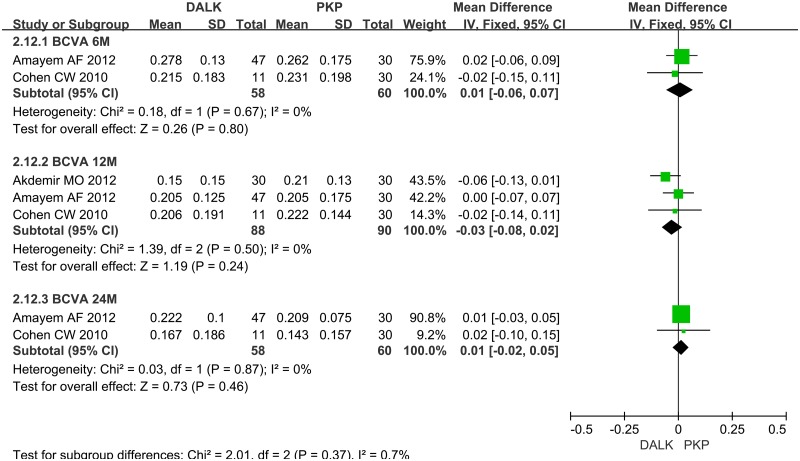
Forest plot comparing the mean LogMAR BCVA between DALK and PK in different time points.CI = confidence interval; SD = standard deviation; DALK = deep anterior lamellar keratoplasty; PK = penetrating keratoplasty.